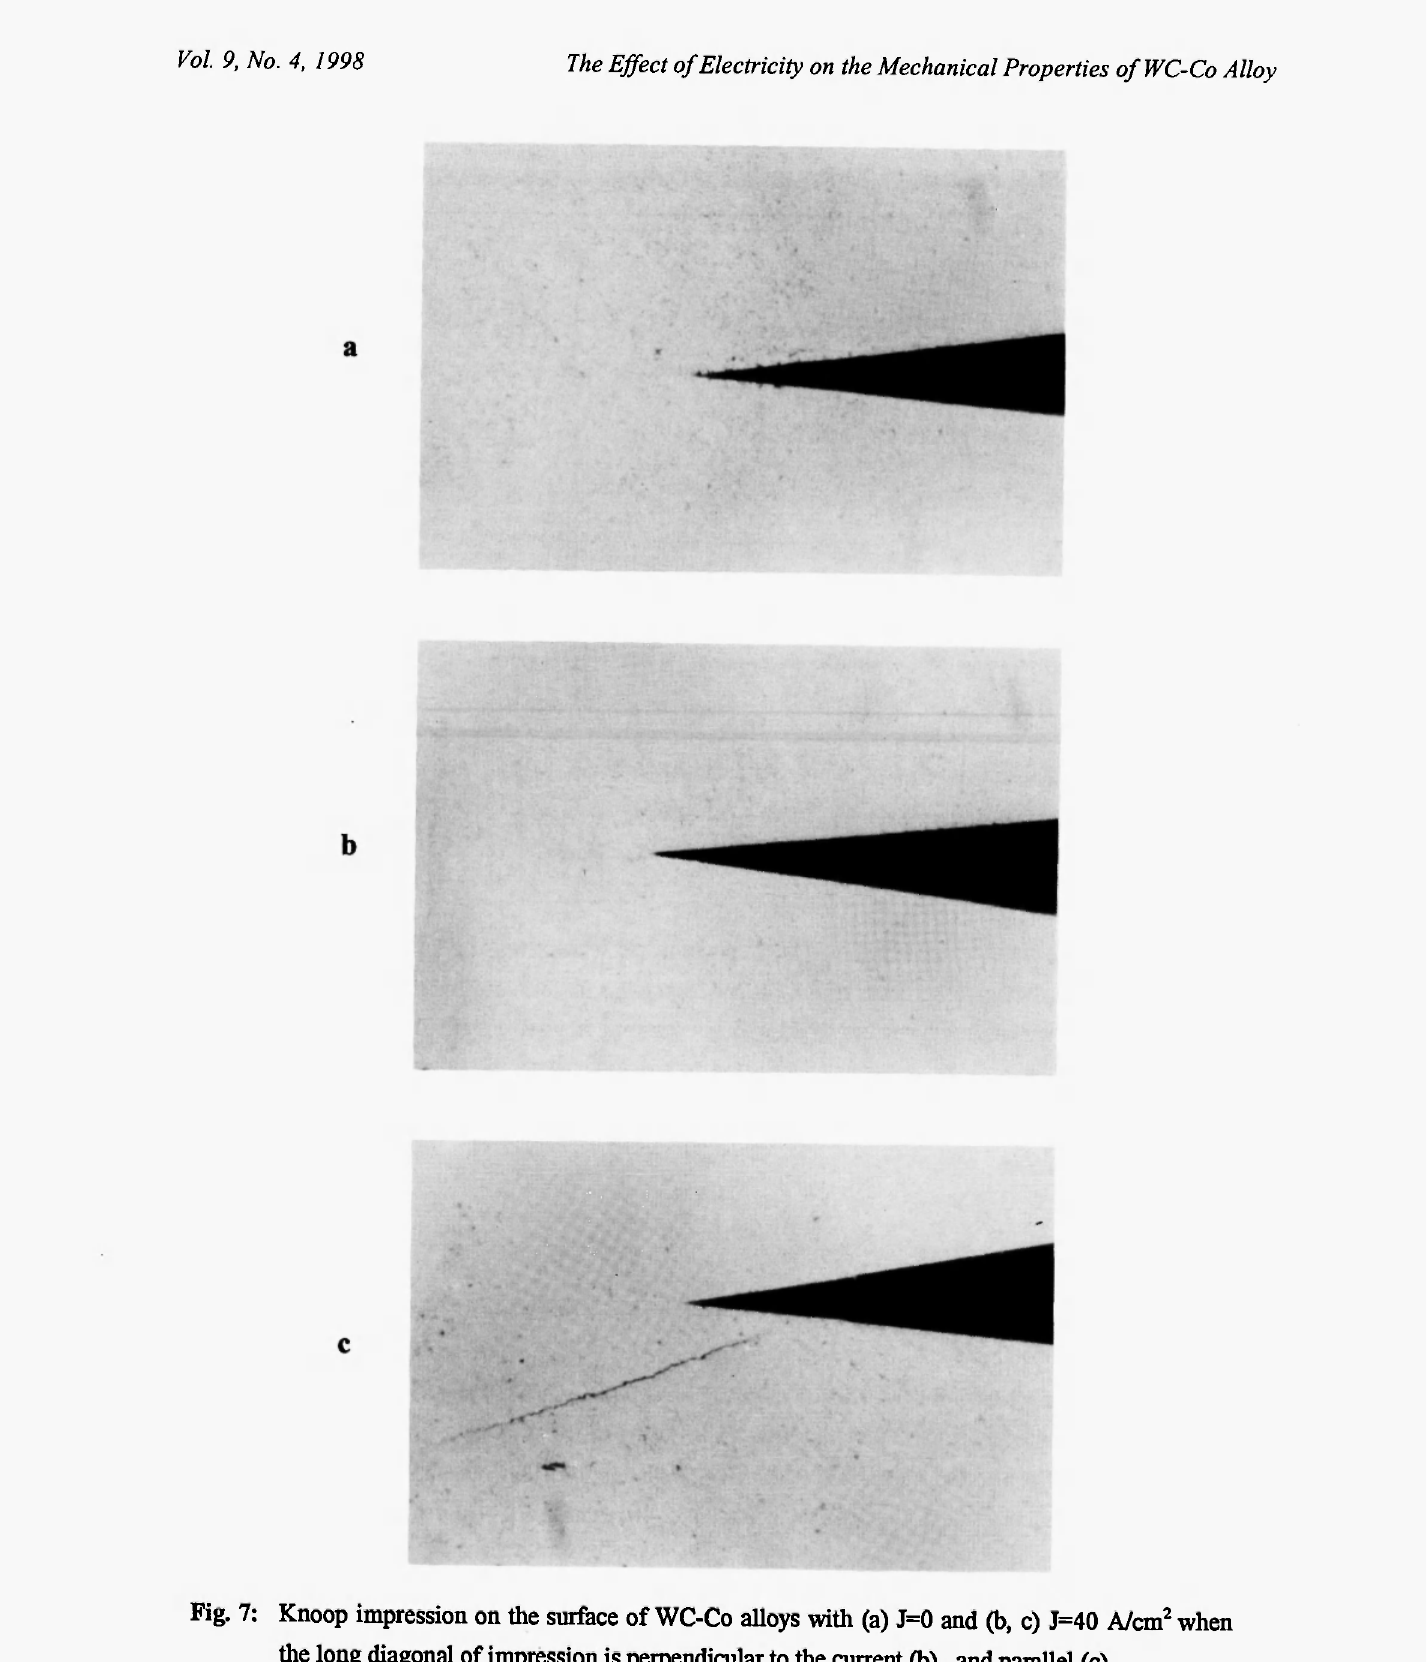
Fig. 7: Knoop impression on the surface of WC-Co alloys with (a) J=0 and (b, c) J=40 A/cm 2 when the long diagonal of impression is perpendicular to the current (b), and parallel